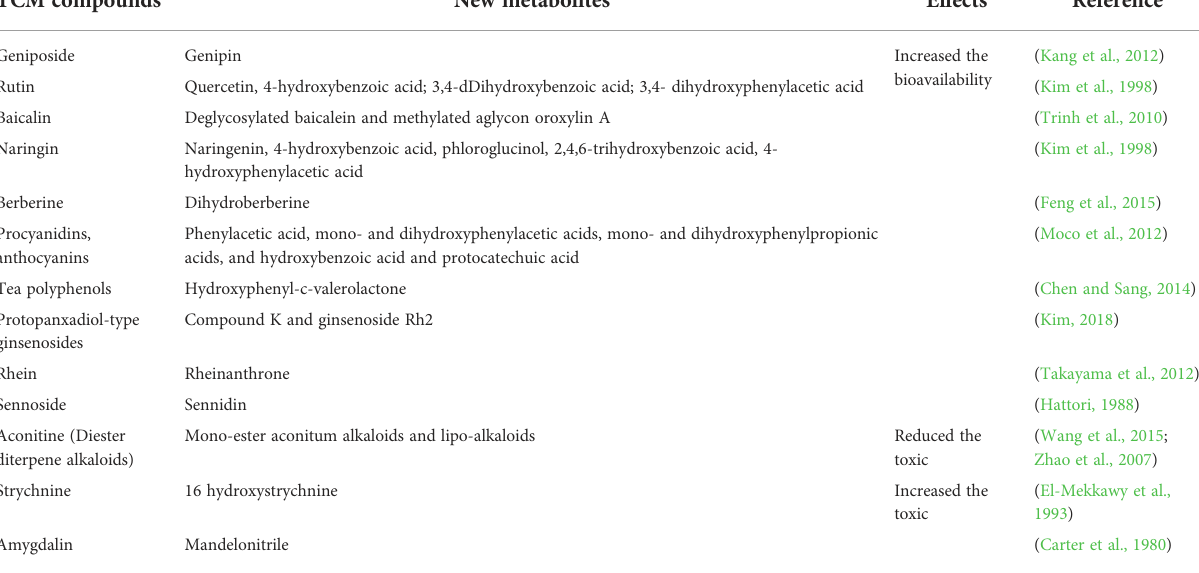
TABLE 2 Transformation of typical TCM compounds by GM.